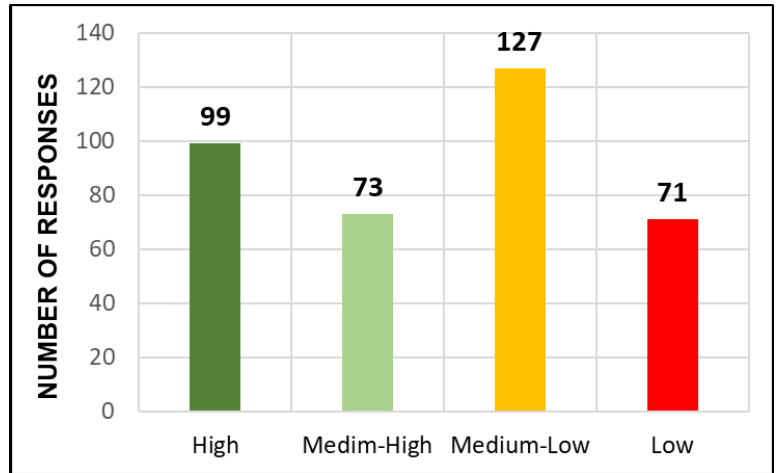
Figure 6. Energy- Use Behavior of Hotel Guests’ Ability Level